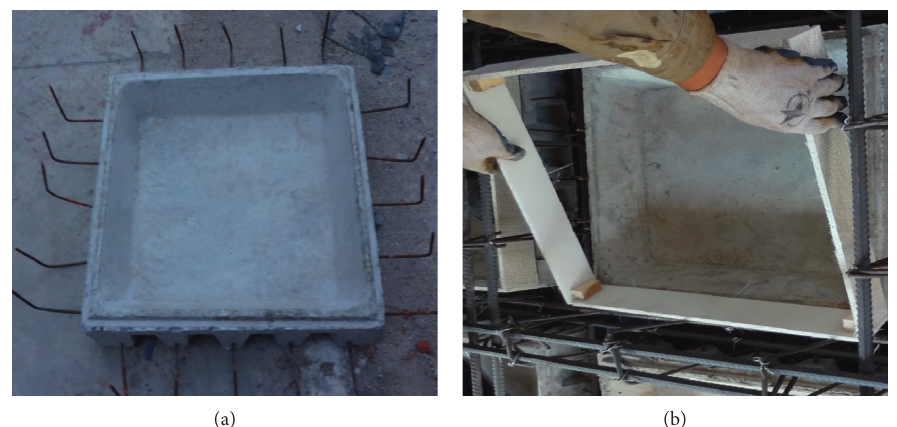
Figure 4: Congruent box. (a) Soleplate or top plate; (b) rectangular frame